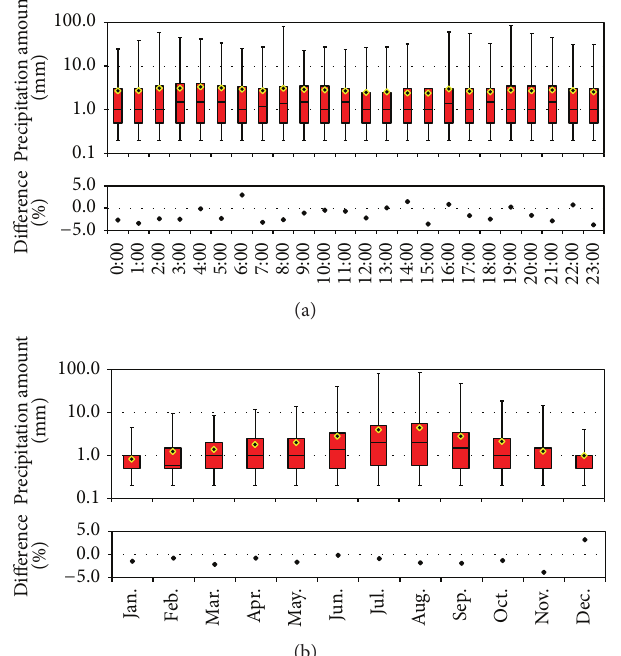
Figure 4: Distribution of (a) hourly and (b) monthly precipitation for all of the 16 meteorological stations over the period of record, excluding time steps without precipitation. The mean of the 15 local stations (black dot) and the mean of the Haean KMA station (gold diamond) are identified. For comparative purposes, the percentage difference of the KMA station relative to the mean of the 15 local stations is